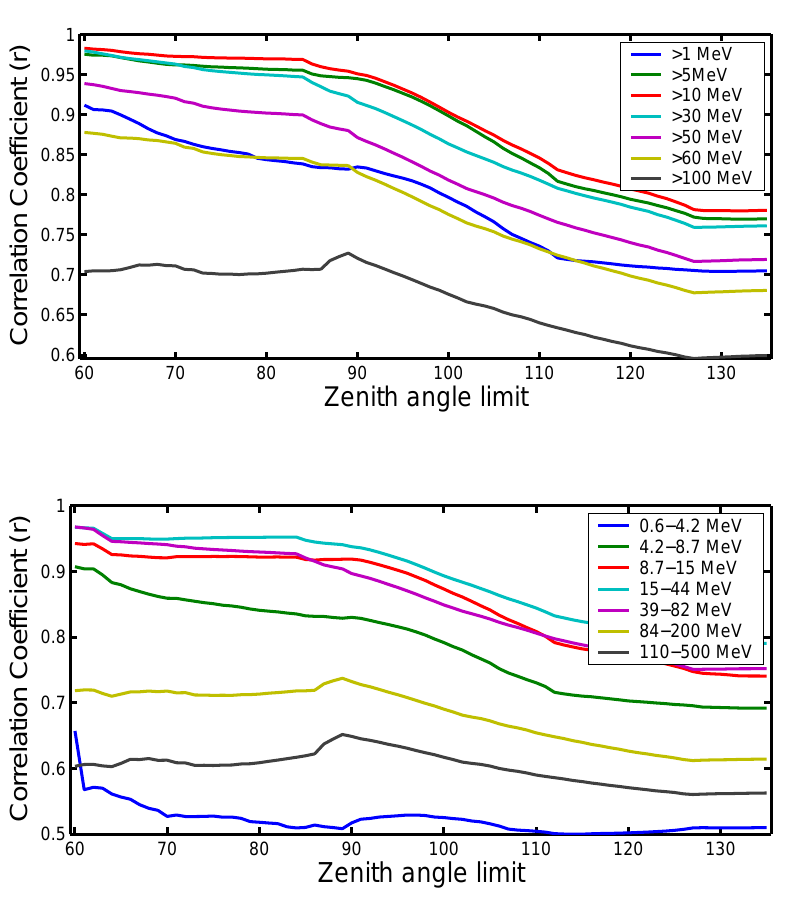
Fig. 5. In the same format as Fig. 4, however, now the differential flux chan- nels from GOES-8 are used instead of the integral